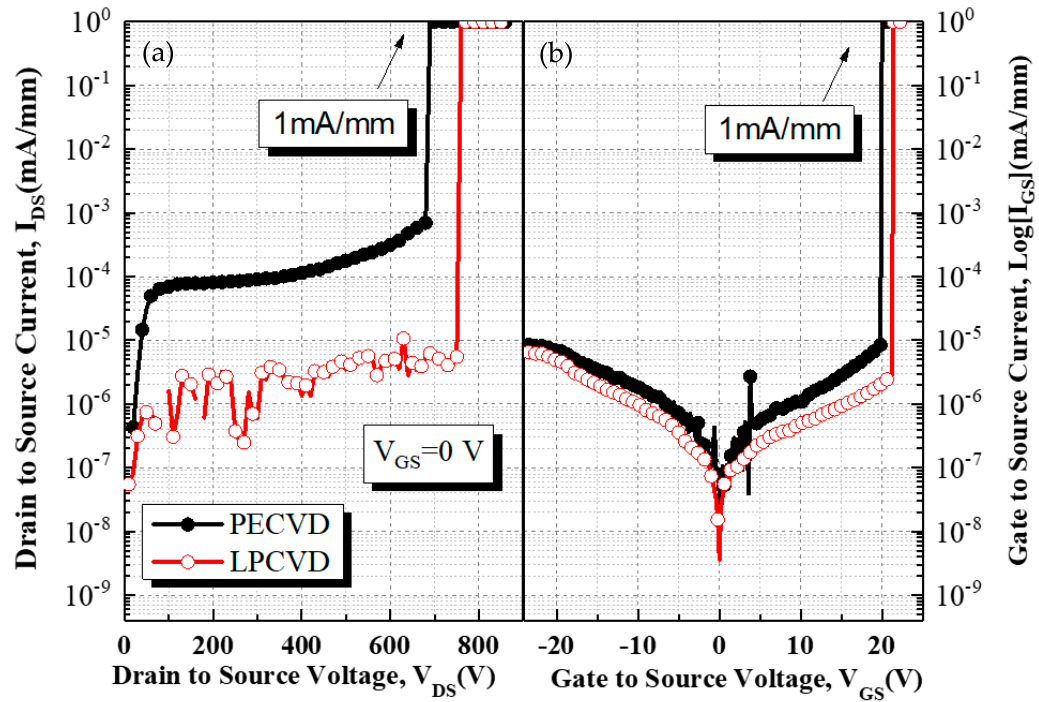
Figure 4. ( a )the three-terminal o ff -state breakdown voltages and ( b )I GS -V GS characteristics for PECVD- Figure 4. (a)the three-terminal off-state breakdown voltages and (b)I GS -V GS characteristics for PECVD- and LPCVD-SiN x passivated UTB and LPCVD-SiN x passivated UTB MISHEMT.